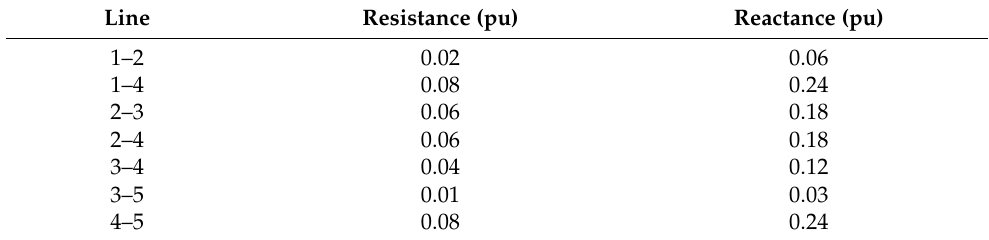
Table A2. Distribution line data of the IEEE 5-bus test distribution system.